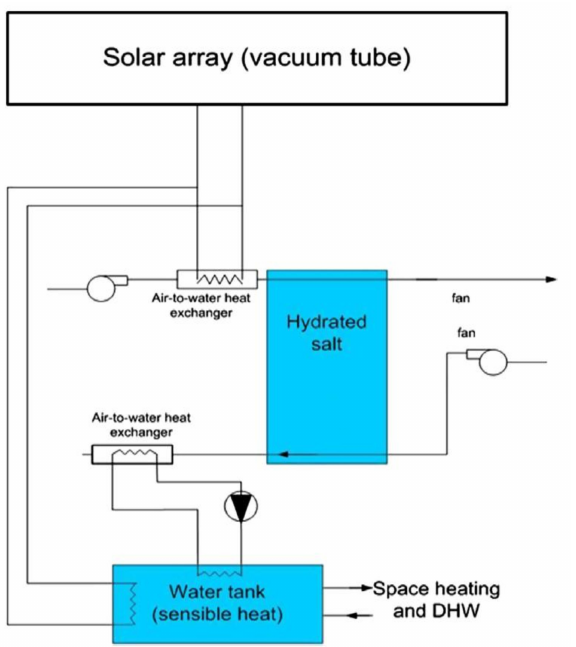
Figure 9. Open thermochemical heat storage for salt hydrates